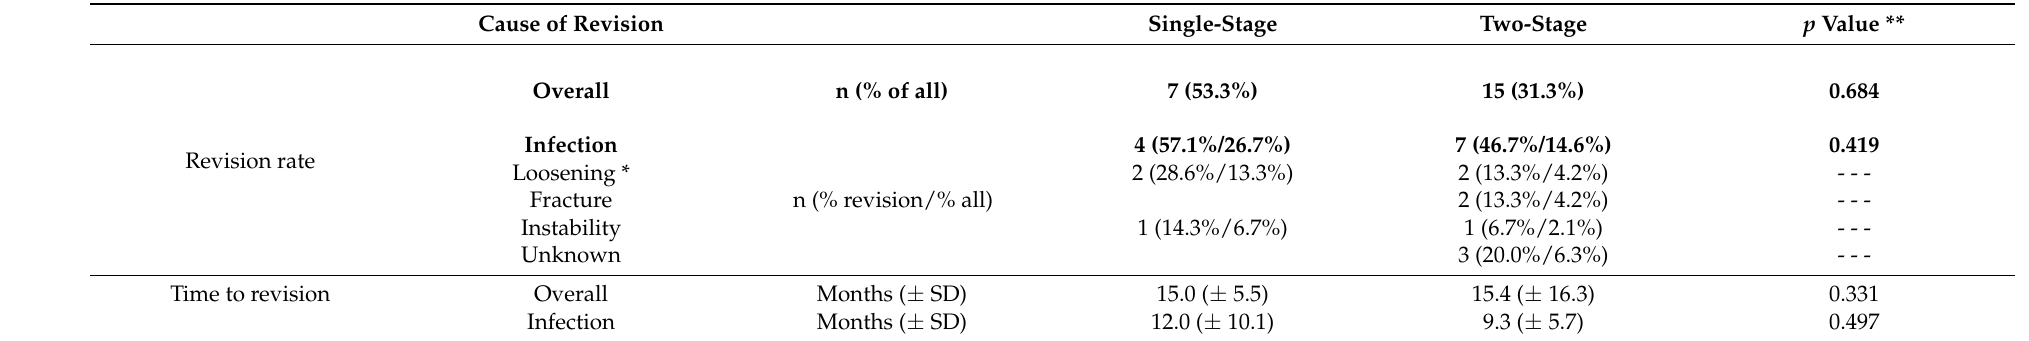
Figure 2. Kaplan–Meier survival analysis following single- and two-stage total knee arthroplasty revision after periprosthetic joint infection: ( a ) survival rate for all causes for re-revision; ( b ) survival rate for recurrence of infection. Table 3. Revision rate analysis at final follow-up.